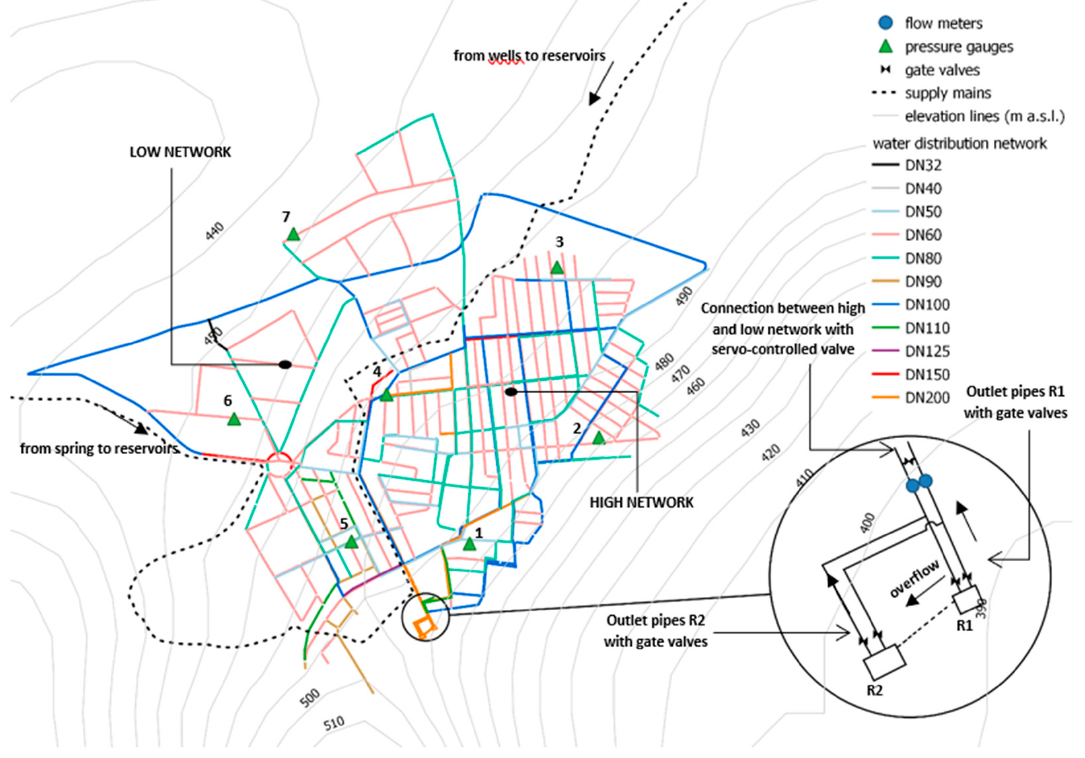
Figure 2. Layout of the WDN of the municipality with indication of sources and reservoirs, and site of installation of pressure gauges and flow